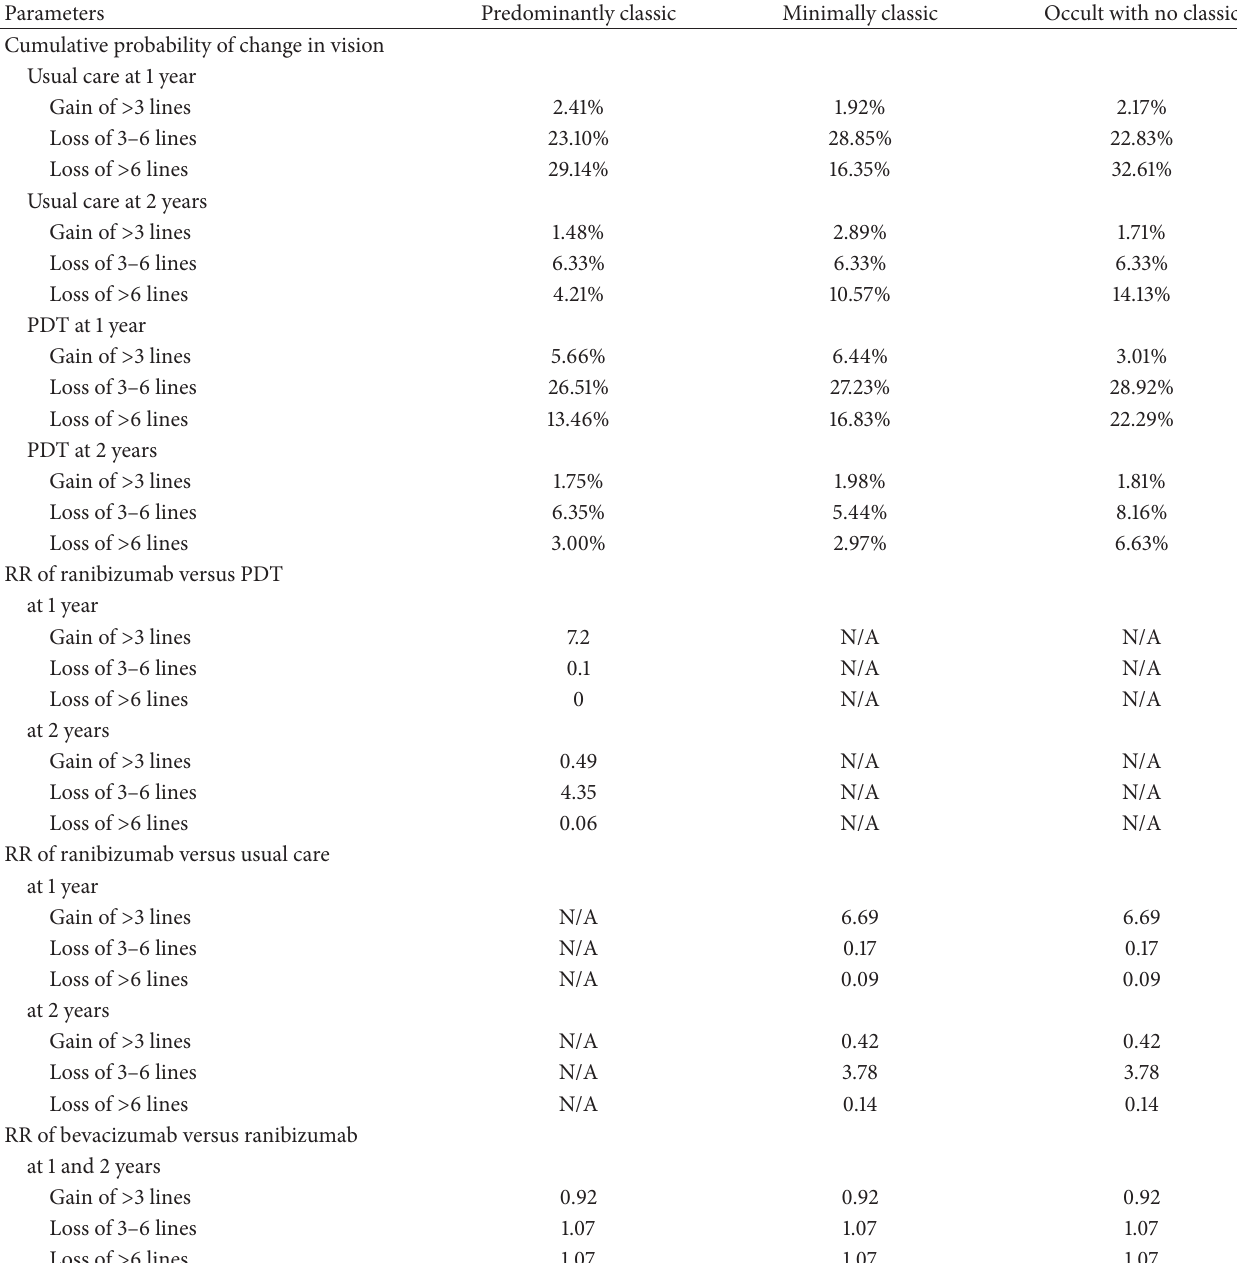
Table 1: Cumulative probability and RR of losing or gaining visual